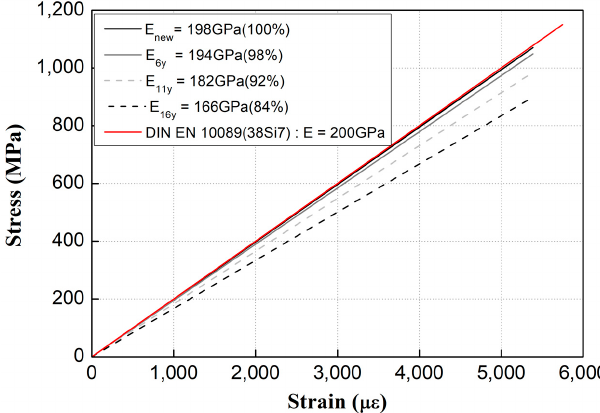
Figure 16. Stress–strain plots showing the variations of the Young’s moduli of the tension clamps.